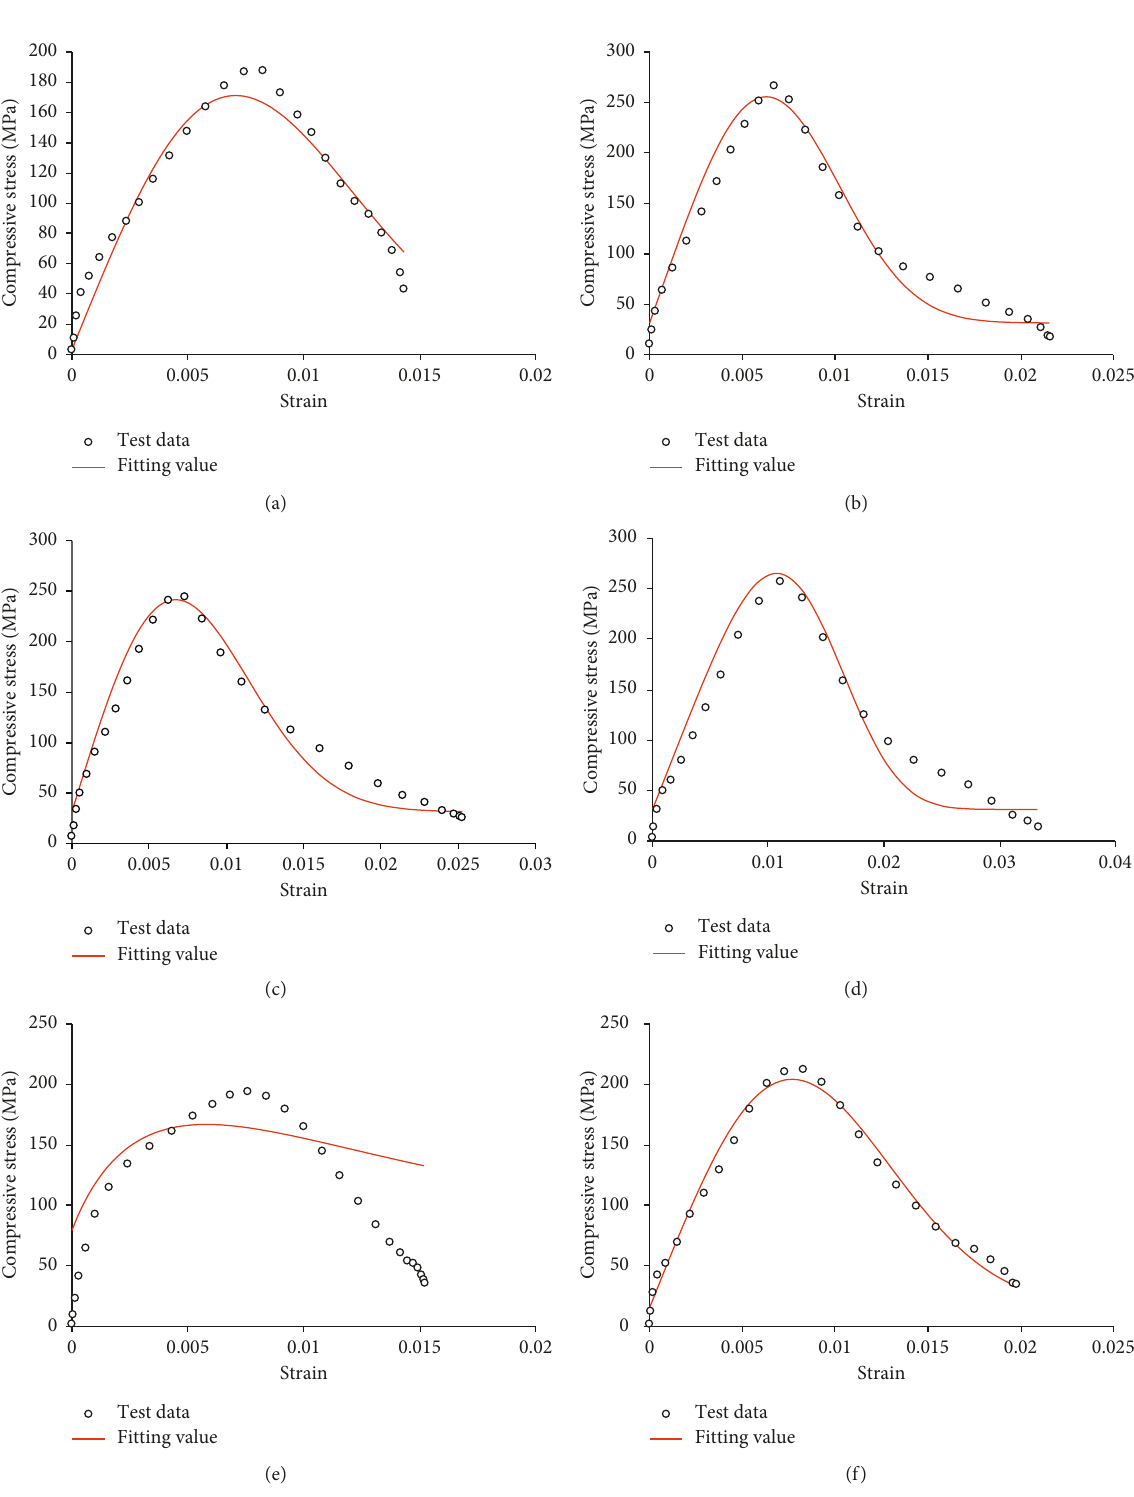
Figure 8: Comparison of the test data and the fitting result obtained for the statistical damage constitutive model: (a) specimen #2; (b) specimen #4; (c) specimen #6; (d) specimen #8; (e) specimen #13; (f) specimen